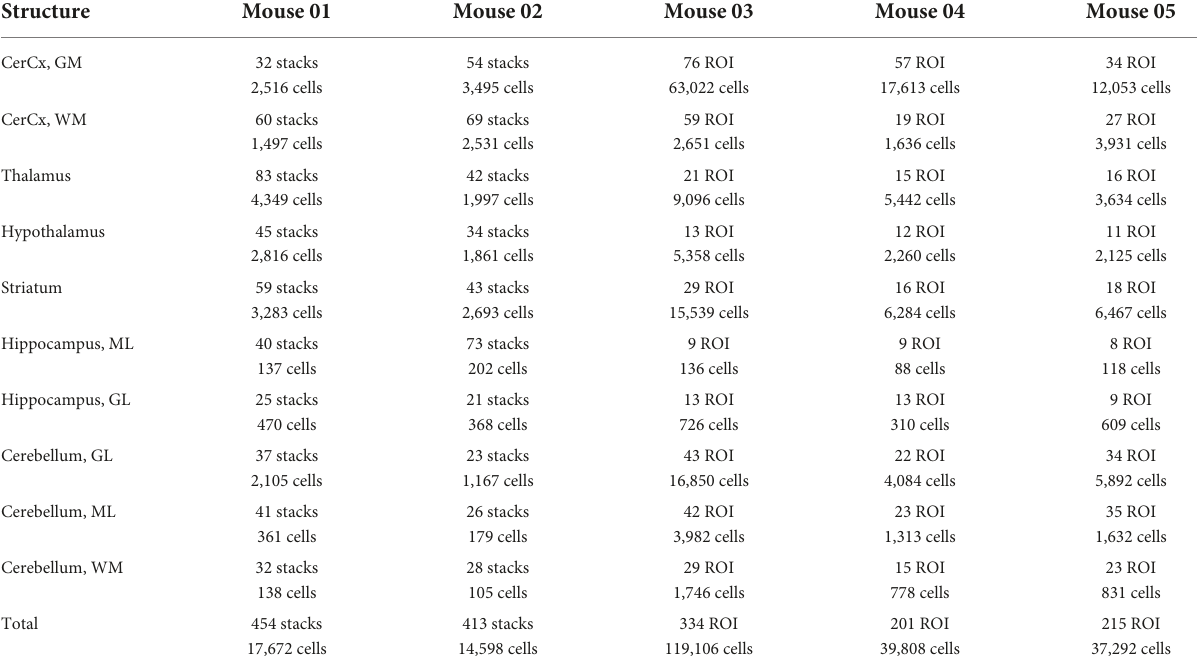
TABLE 1 Numbers of cells, stacks and ROIs analyzed in each of ten structures of interest in the mouse brain. Structure